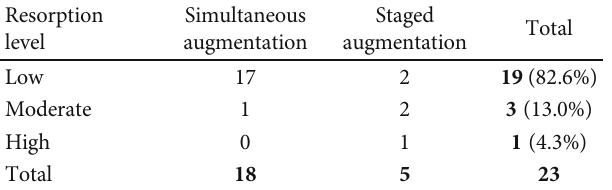
Table 2: The distribution of tissue resorption level after implant placement associated with simultaneous and staged approaches.